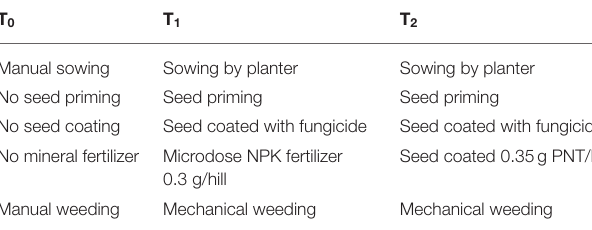
TABLE 2 | Description of the three treatments. T 0 T 2 Manual sowing Sowing by planter Sowing by planter